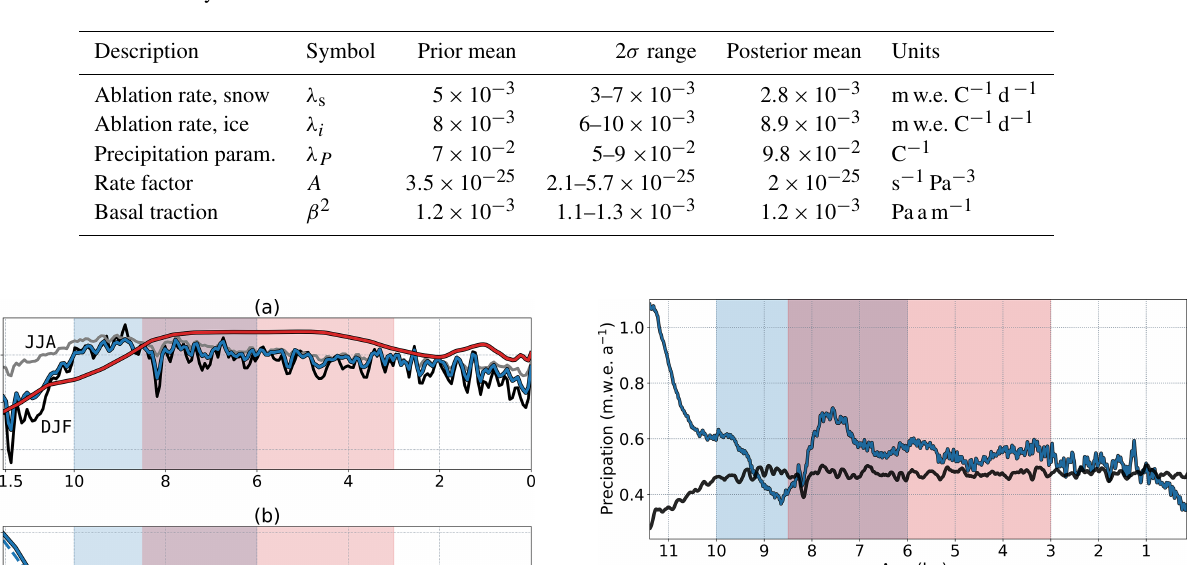
Table 3. Summary of primary model parameters used in this work. Default values are provided where applicable. Prior parameter uncertain- ties assumed for the sensitivity test are shown in the 2 σ column.